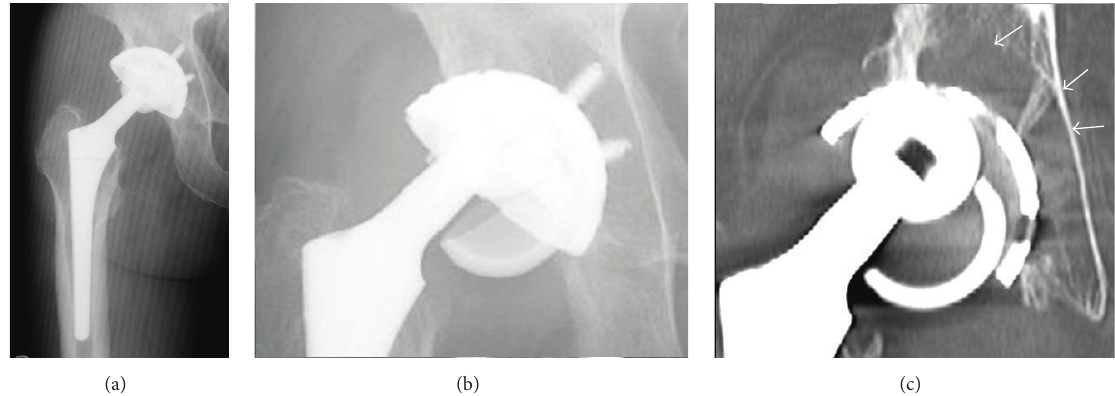
Figure 1: A postoperative anteroposterior radiographic image showing primary THA with alumina-on-alumina bearings on the right side for the treatment of secondary osteoarthritis due to developmental dysplasia of the hip (a). A plain radiograph and a computed tomography (CT) image, obtained 10 years after primary THA, showing the liner’s dissociation from the metal shell along with retroacetabular osteolysis (white arrows) (b and